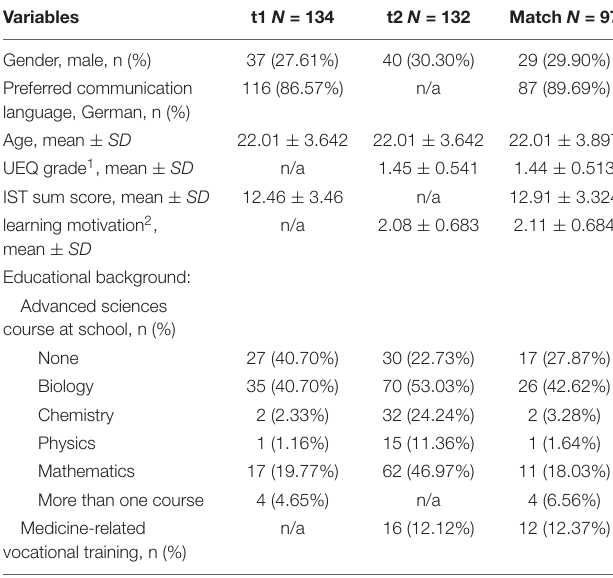
TABLE 2 | Descriptive statistics for the samples at t1, t2, and for the matched sample.